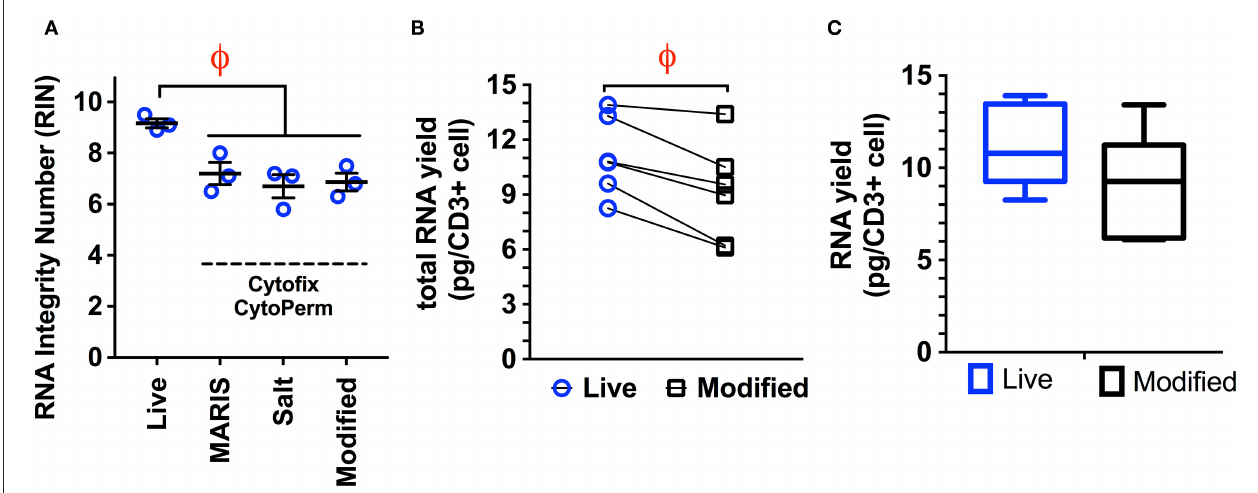
FIGURE 1 | (A) Comparison of RNA integrity numbers (RIN) from live cells and cells isolated using the MARIS, High Salt (2M NaCl), and modified protocol for the isolation of RNA from fixed and permeabilized samples. Data is represented as the RNA integrity number (RIN) following all processing, staining, and sorting steps (viable, CD14–, CD3 + ; n = 3 per condition). While there is a significant reduction in RIN from live cells to those isolated following all three of the above protocols, there is no significant difference between either of the three protocols with regard to RNA quality, with all three producing RNA with acceptable quality. (B,C) . RNA yield obtained using the modified protocol demonstrating a small but significant reduction (18%) in total RNA yield when comparing live cells and those processed using the modified protocol ( n = 5). This mild reduction in RNA quantity would have a minimal impact on the number of cells required to generate adequate RNA libraries. Statistical testing: φ p <